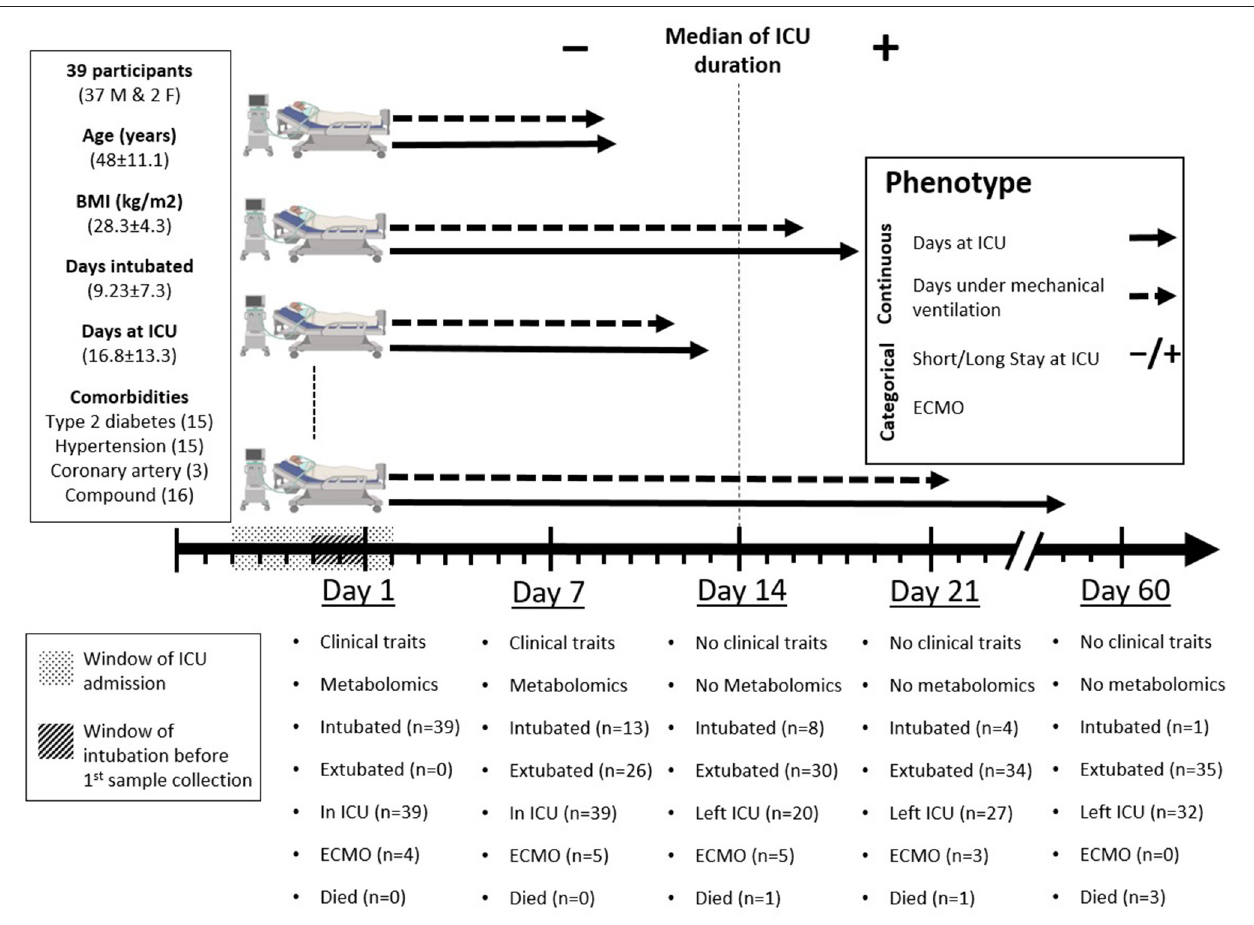
FIGURE 1 | Study design. Day one represents the day of inclusion and first sample collection when all participants were already under mechanical ventilation. Patients’ intubation started 2 days before to 4 days after ICU admission (window of intubation). Blood samples were collected from intensive care unit (ICU) patients 1 day before ICU admission to 5 days after ICU admission (window of ICU admission), then 7 days later. Clinical and metabolic profiles were measured at day one and day seven and were correlated with four phenotypes: two continuous (days at ICU and days under mechanical ventilation) and two categorical [short ( ≤ 14 days) or long ( > 14 days) stay at ICU and progression to ECMO]. Clinical outcomes were recorded at days one, seven, fourteen, twenty-one, and sixty. Participants’ data for age, body mass index (BMI), days under mechanical ventilation, and days at ICU are presented as mean ± standard deviation